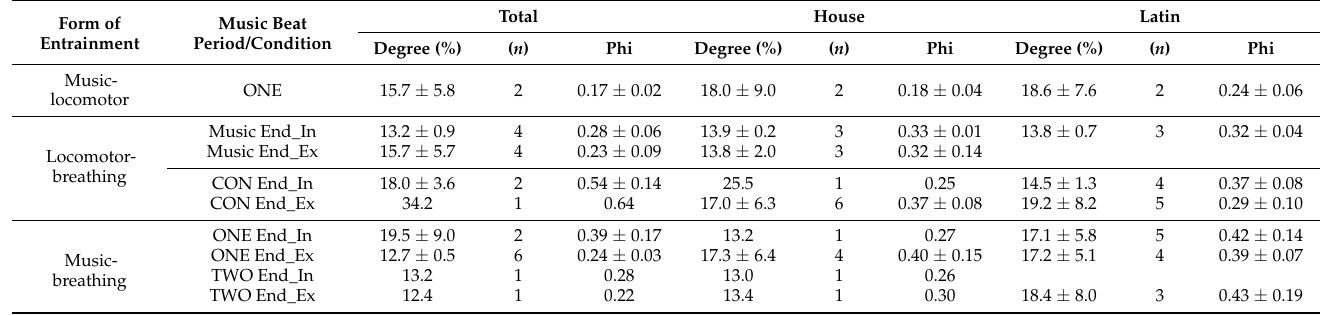
Table 2. Presence, degree, and magnitude of entrainment for the music-locomotor, locomotor- breathing, and music-breathing entrainment analyses, when considering all the music tracks together or the House and Latin tracks